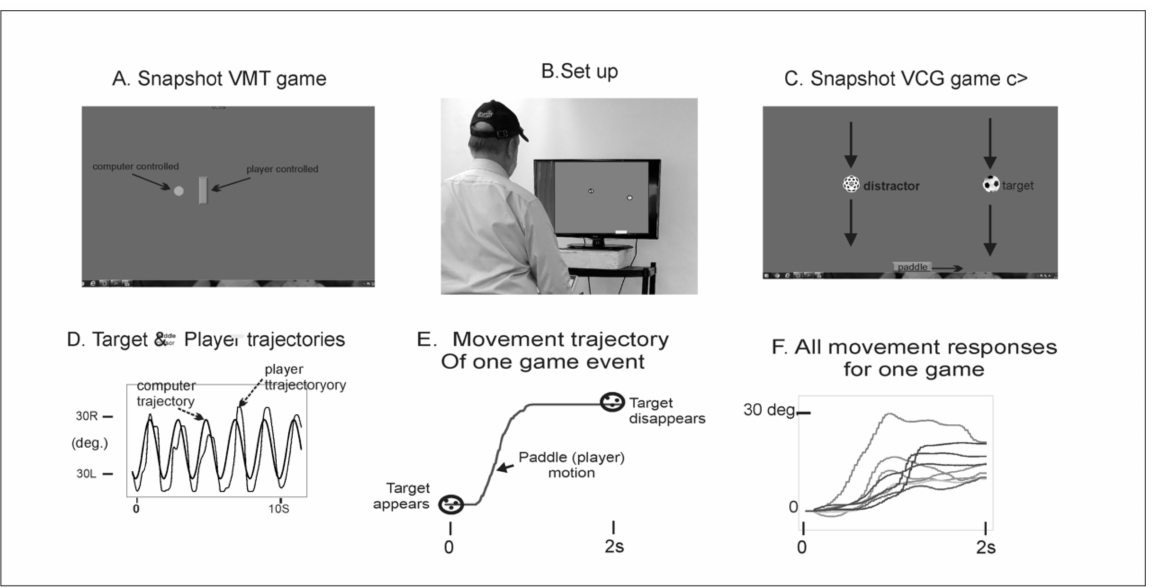
Figure 2. Illustration of the assessment game setup. As presented in Panel ( B ), the participant stands while viewing a computer monitor. An inertial-based mouse is secured to the sports cap, and head rotation is used to interact with the visuospatial cognitive games. Panels ( A , C ) present snapshots of the VMT and VCG modules. Panel ( A ) (VMT) shows cursors of different shapes appearing on the computer monitor. The target is a circle, and its motion was computer-controlled and moved at a predetermined frequency of 0.5 Hz with an amplitude of 70% of the monitor width. The second cursor is a rectangle, which is slaved to the head-mounted IB mouse. Children were instructed to rotate their heads and overlap the rectangle cursor with the target circle for several cycles (i.e., 30 s). The coordinates of the rectangle and target cursor were recorded at 100 Hz for offline analysis. Panel ( D ) presents synchronous plots of the target cursor motion and user movement trajectories (head rotation) for a typical VM tracking task. The maximum is the leftmost position, and the minimum is the right-most position. Panel ( C ) (VCG) objects are categorized as targets or distractors. The game objects appear at random locations at the top of the display every 2 s and move in a diagonal trajectory to the bottom of the display. Children were required to move the paddle to catch the target objects while avoiding the distractors. The coordinates of the game paddle and target objects were recorded (100 Hz) for offline analysis of the success rate (SR). Panel ( E ) presents the trajectory for one VCG game movement response from target appearance to target disappearance. Panel ( F ) presents overlay trajectories of all game movement responses for one game